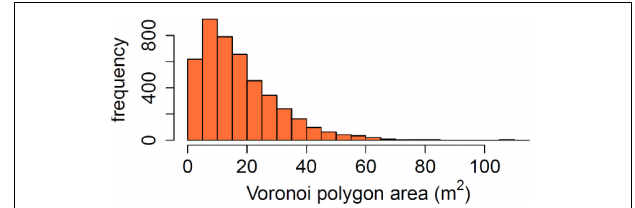
FIGURE 5 | Distribution of area potentially available for individual trees calculated as Voronoi polygon area. Calculated from tree locations treated as points in a plane, the Voronoi polygon of each tree is defined as the planar area within which the tree is the closest tree of